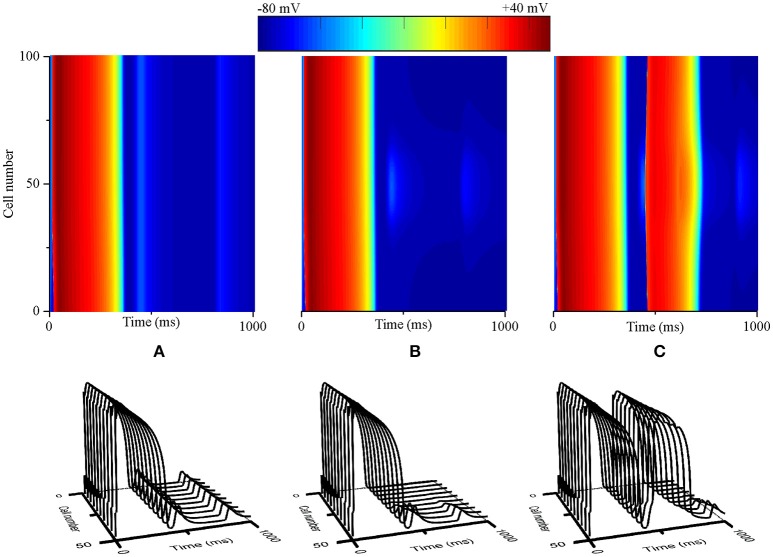
Requirements for delayed afterdepolarizations (DADs) to produce a premature ventricular complex (PVC) in the 1D cable in which a central region of contiguous myocytes exhibiting DADs was surrounded by normal cells. (A) No PVC produced due to subthreshold DADs in the central region. (B) No PVC generated, though cells in the central region exhibiting suprathreshold DAD but the length of the region is under a critical value (e.g., 24 cells). (C) A PVC generated as the length of the region exhibiting suprathreshold DAD is over a critical value (e.g., 25 cells).